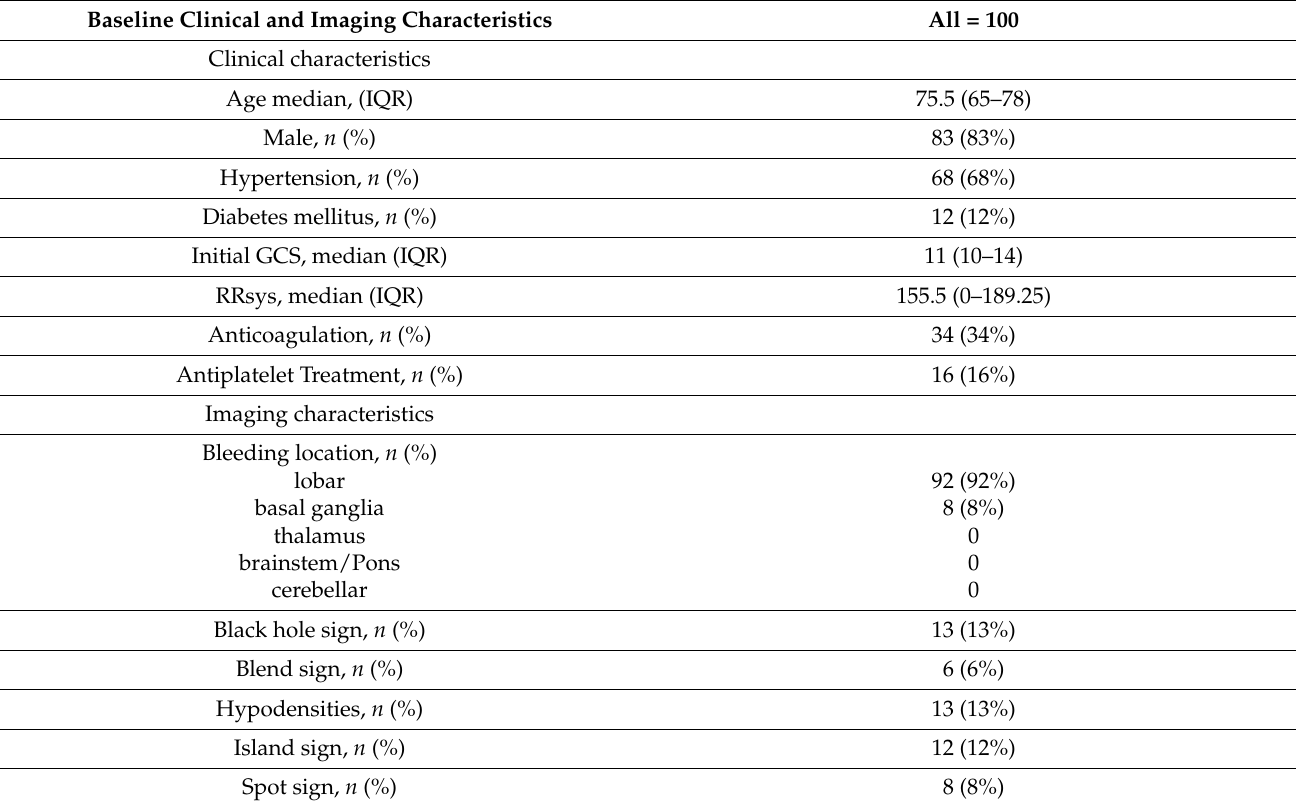
Table 1. Demographic